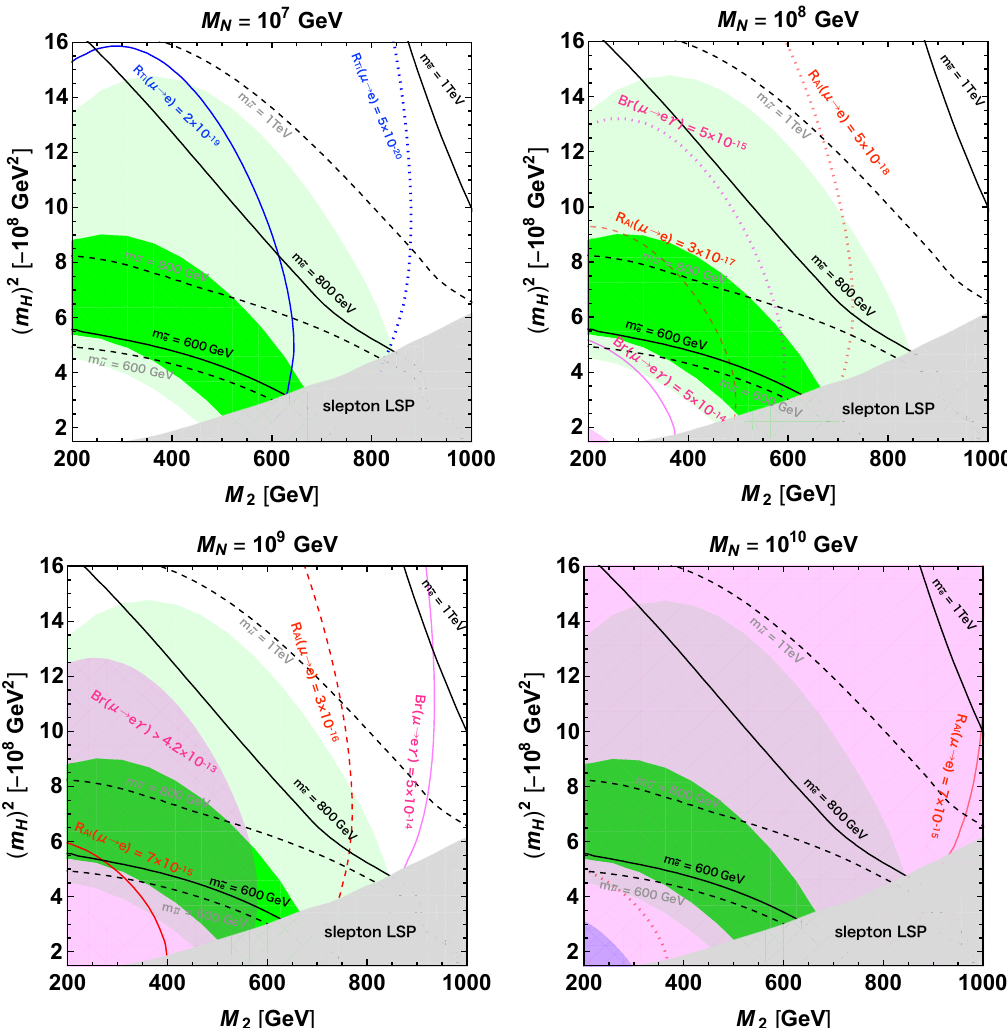
Figure 6 . Contours of the muon g − 2 and LFVs in the model B with the degenerated RH neutrinos. We take M 3 = − 4 TeV, tan β = 40 and m 2 to the future sensitivity of µ → eγ , Br ( µ → eγ ) ≈ 5 × 10 − 14 , at MEG-II [83]. The red and dashed red lines are the future sensitivities of µ − e conversion in Al at COMET Phase-I [84] and COMET phase II [85], which correspond to R ≈ 3 × 10 − 17 respectively. Mu2e [86] gives similar sensitivity as COMET phase II. The blue line is the future sensitivity of µ → e conversion in Ti, R